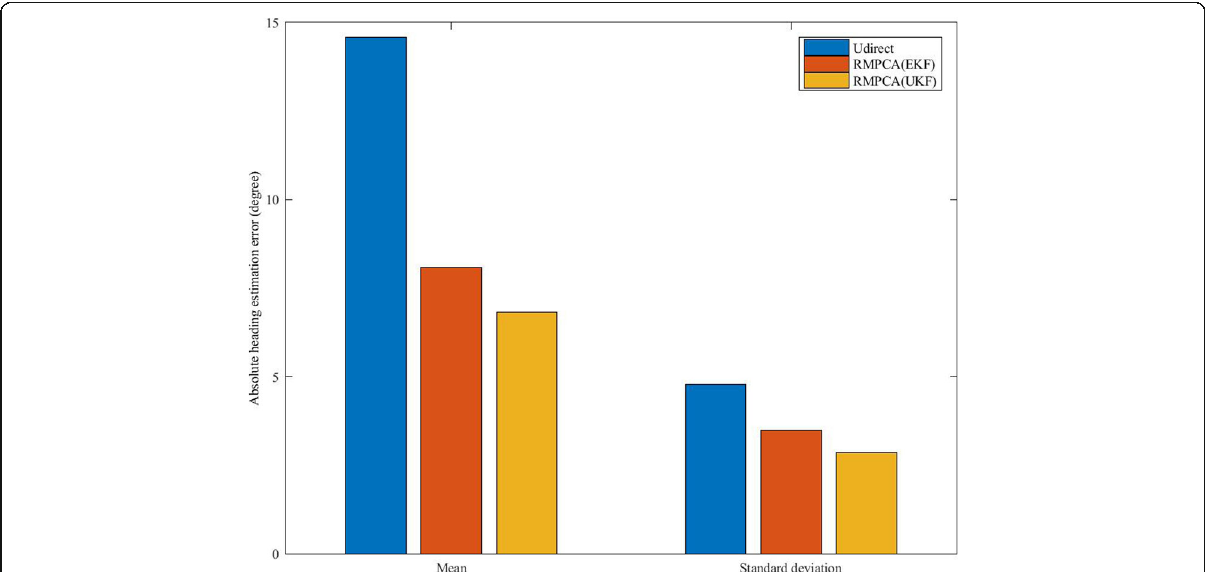
Fig. 4 Performance comparisons of mean and standard deviation of absolute heading estimation